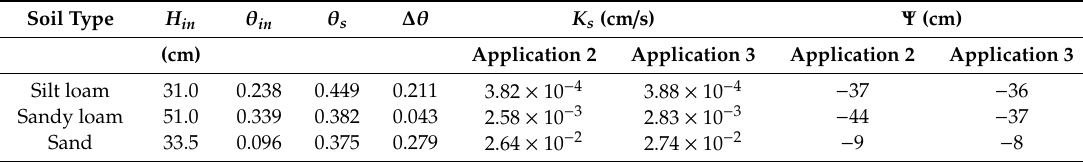
Table 3. The most optimal sets of K s and Ψ (with the highest NSE values) determined using Application 2 and 3 as described in the flowchart (see Figure 2) with measured ∆ θ , H in , θ in , and θ s (input data) for the three tested soils (silt loam, sandy loam, and sand).